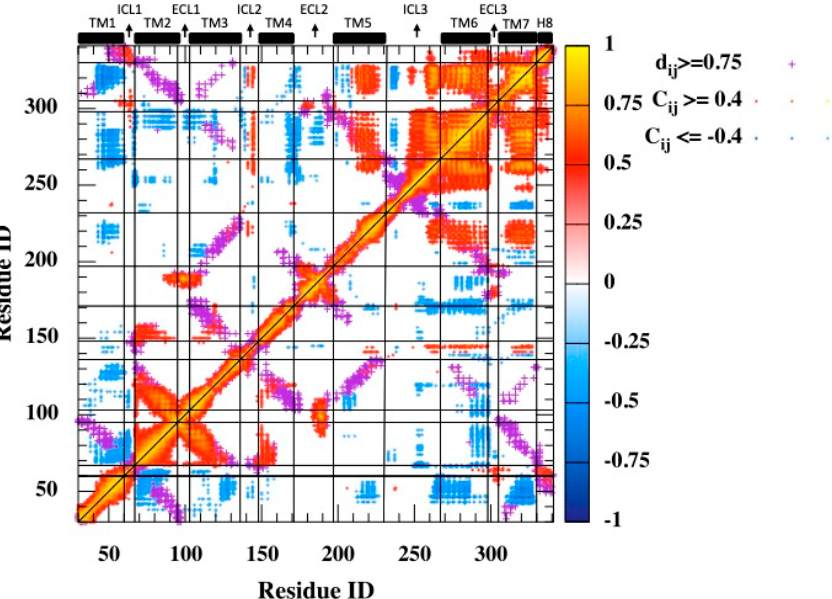
Figure 2. Residue-pair cross-correlation map for 3 µ s MD trajectory. Only C ij > + 0.4 and C ij < − 0.4 are represented. Magenta dots represent the contact map (threshold distance of 6 Å).